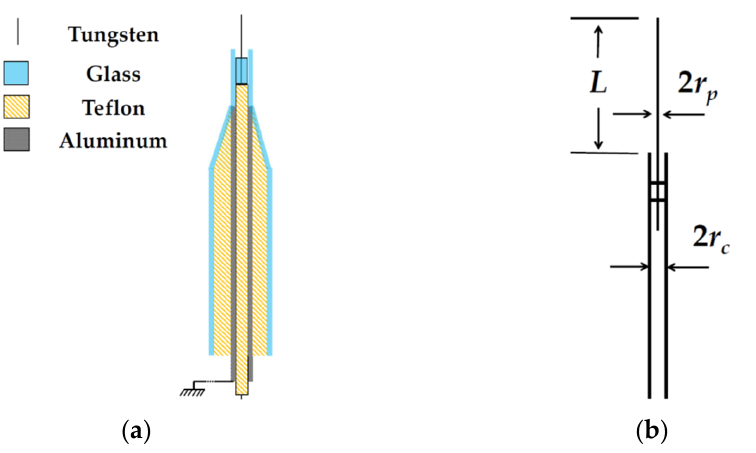
Figure 2. ( a ) Probe scheme. ( b ) Relevant dimensions of a Langmuir cylindrical electrostatic probe design.